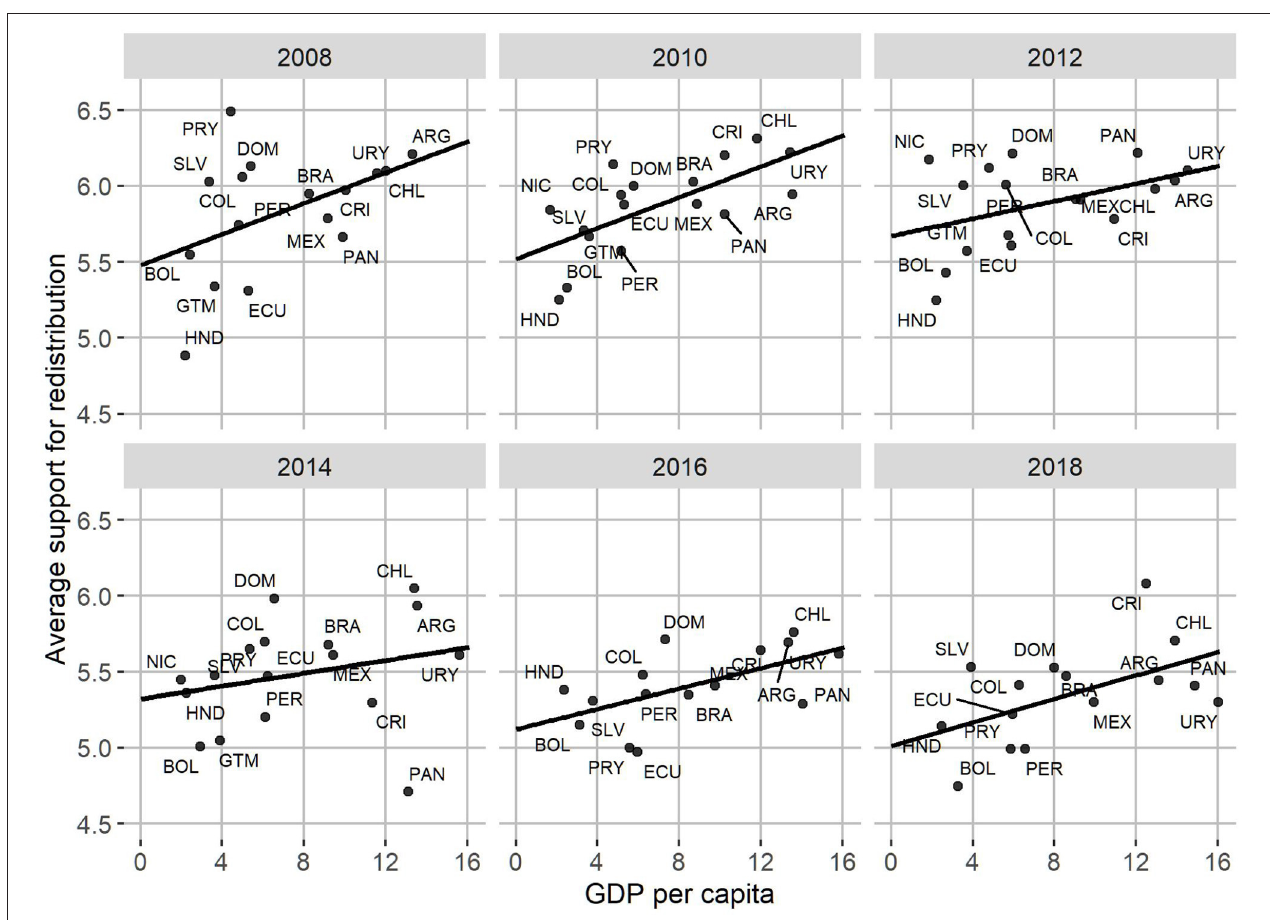
FIGURE 5 | Average support for redistribution and GDP per capita, by country and